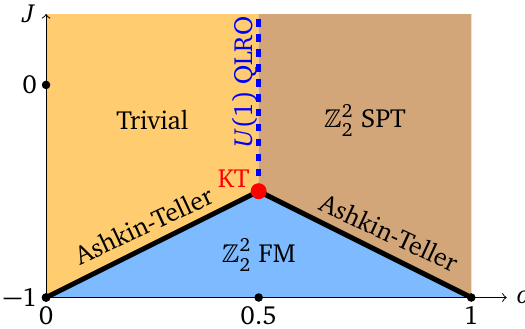
Figure 3: Phase diagram of the 1D cluster SPT transitions perturbed by a second- nearest-neighbor Ising interaction: Hamiltonian (15), which is dual to the XXZ chain by gauging the diagonal (cid:90) symmetry. The vertical α = 1 / 2 has an exact U ( 1 ) sym- 2 metry generated by the Ising pivot H . The blue dashed line is a compact boson pivot transition between the trivial and cluster SPT phase. As we tune J to be large and negative, there is a KT transition into a ferromagnet with fourfold ground state de- generacy. This symmetry-broken phase is separated from the symmetry-preserving phases by an Ashkin-Teller